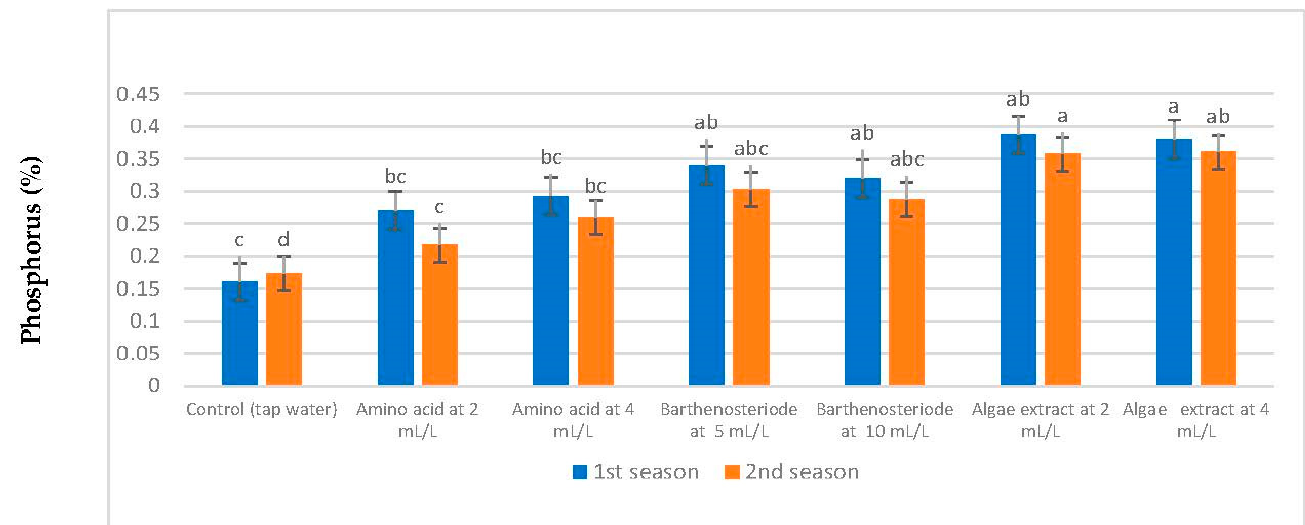
Figure 2. Effect of various bio-stimulant treatments on phosphorus (%) of chia (Salvia hispanica L.) plants during the 2019–2020 and 2020–2021 seasons. For the same column, means followed by the same letter are not statistically different, according to the Tukey multiple range test (TMRT) at p ≤ 0.05.